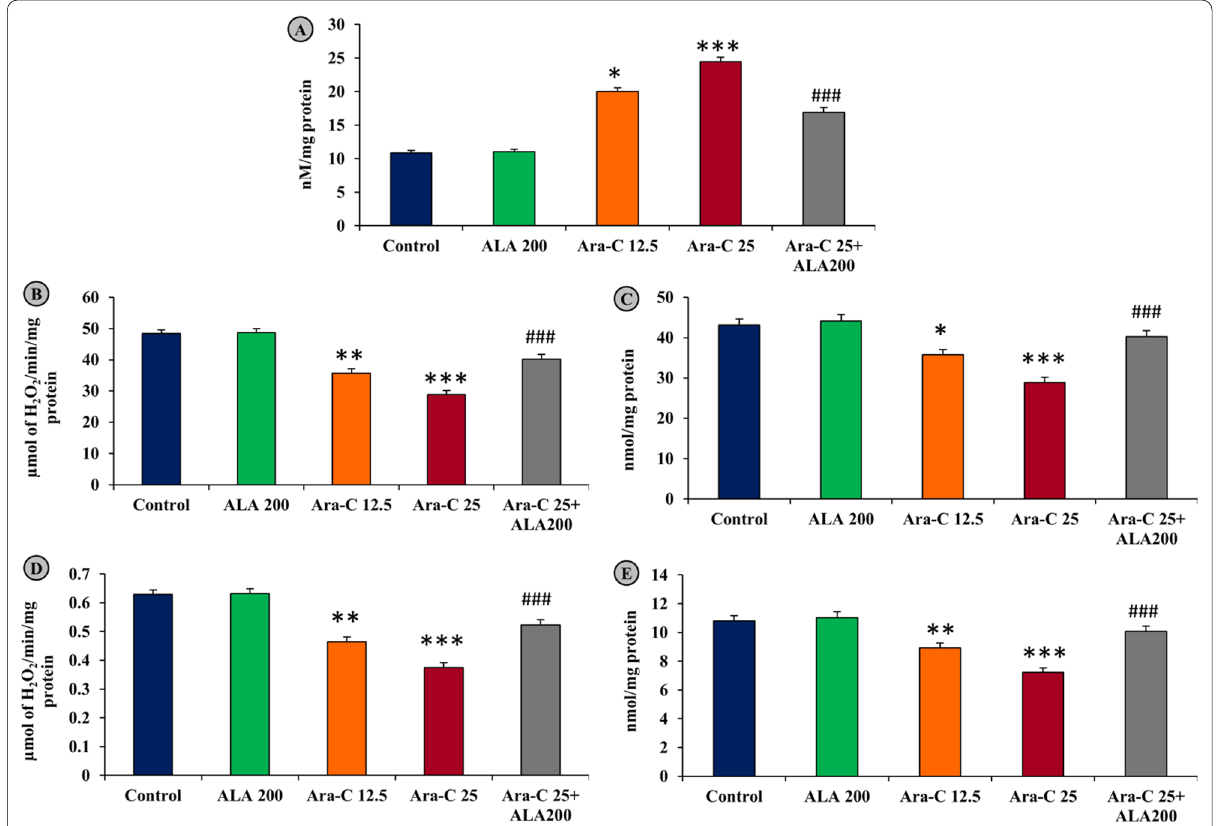
Fig. 2 Effect of Ara-C and ALA on maternal oxidative stress markers, A MDA, B SOD, C GSH, D GSH-Px, and E Catalase. All the values are expressed as mean SEM, (n 6). *** P < 0.001 versus control, ** P < 0.01 versus control, * P < 0.05 versus control; ### P < 0.001 versus Ara-C 25 mg/kg. ALA ± = alpha-lipoic acid, Ara-C cytarabine, GD gestation day, GSH glutathione, GSH-Px glutathione peroxidase, g grams, MDA malondialdehyde,